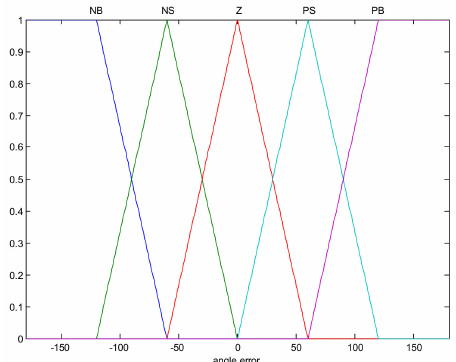
Figure 25. Membership functions of the degree error.